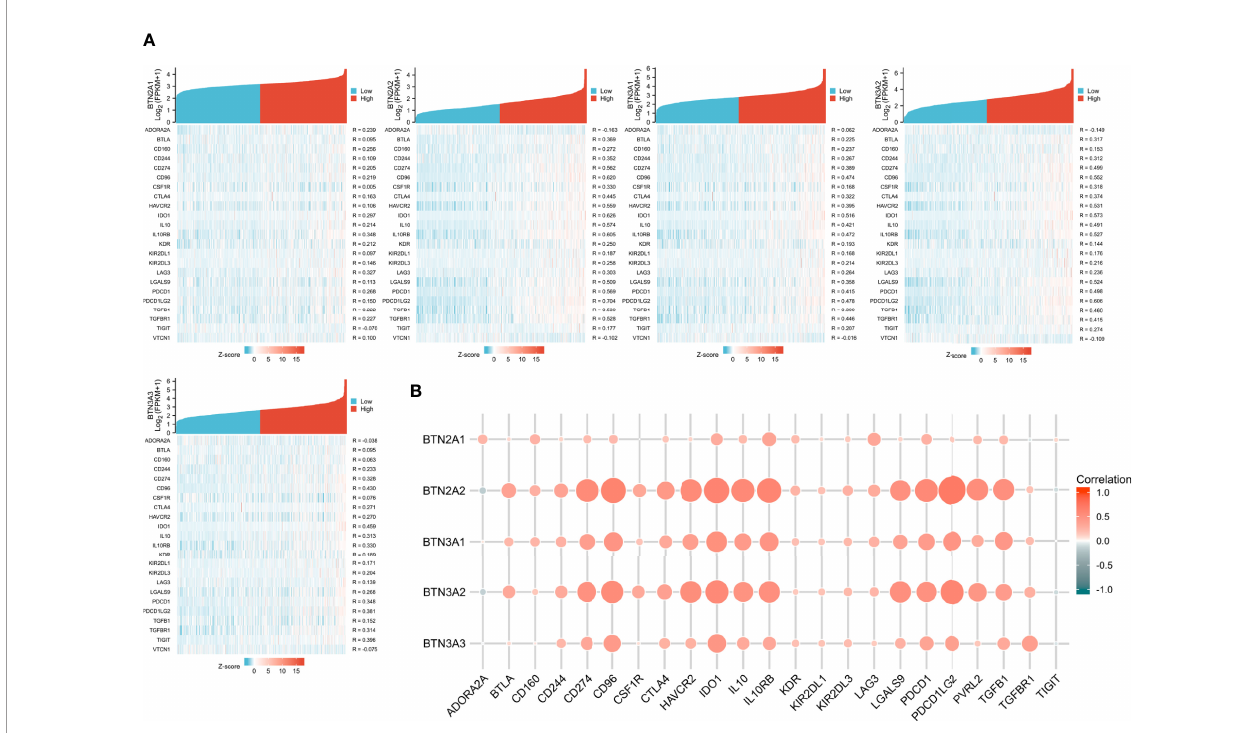
FIGURE 5 | Correlations of BTN2/3 subfamily expression and immune inhibitors in pan-glioma. (A) Single-gene correlation heatmap of BTN2/3 subfamilies and the TISIDB immune inhibitory dataset. (B) Overview heatmap of BTN2/3 subfamily members and the TISIDB immune inhibitory